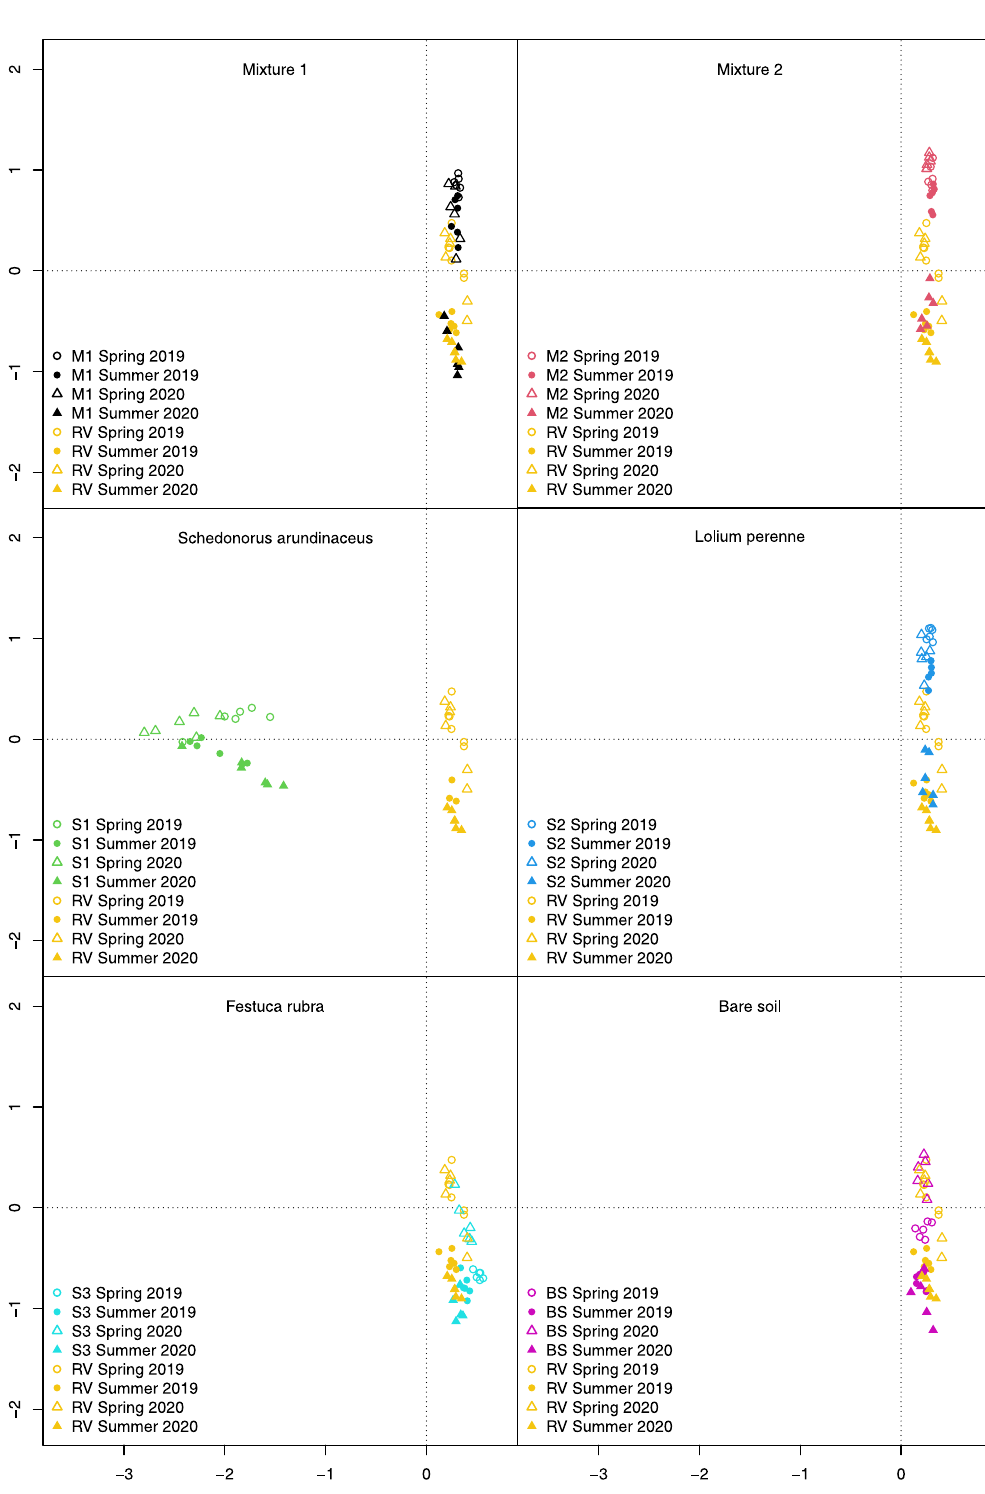
PLOS ONE | https://doi.org/10.1371/journal.pone.0279759 December30, 2022 10 /